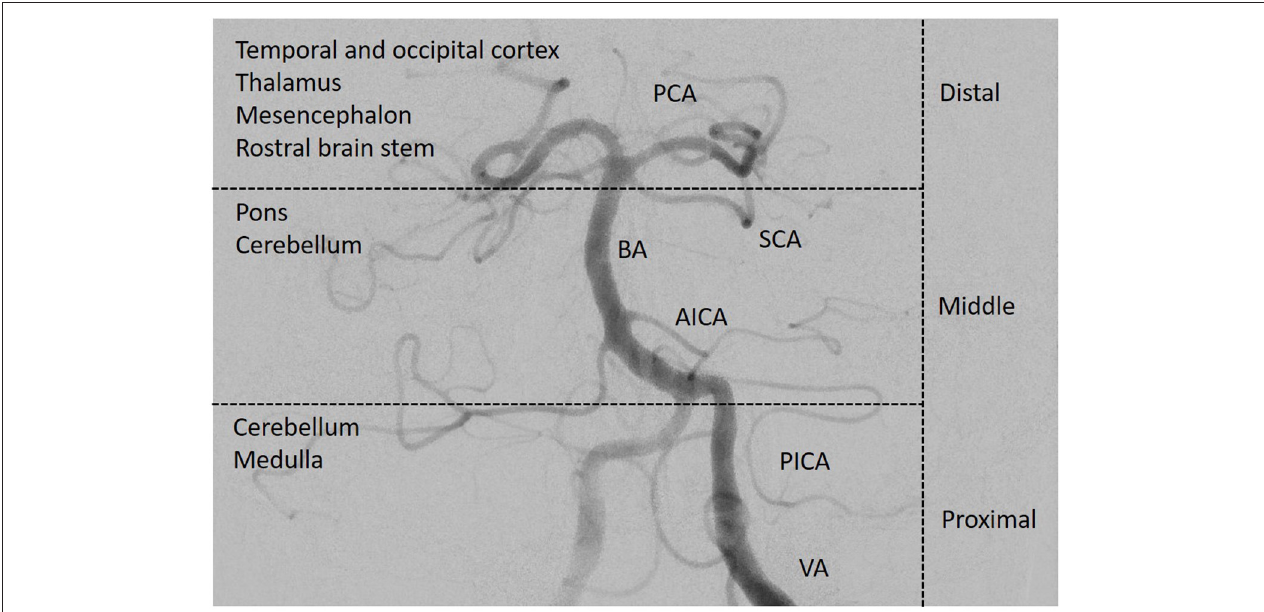
FIGURE 1 | Posterior circulation vasculature. The vessels of the posterior circulation can cause multi-level strokes in different anatomical regions of the posterior circulation. The complexity of especially the structures in the brainstem makes localization of clinical signs and the site of infarction more difficult than in the anterior circulation. Angiography of the left vertebral and basilar artery. PCA, posterior cerebral artery; SCA, superior cerebellar artery; BA, basilar artery; AICA, anterior inferior cerebellar artery; PICA, posterior inferior cerebellar artery; VA, vertebral artery; distribution according to the New England Medical Center Posterior Circulation Stroke Registry ( 3). ( Image courtesy of C. Herweh, Frankfurt